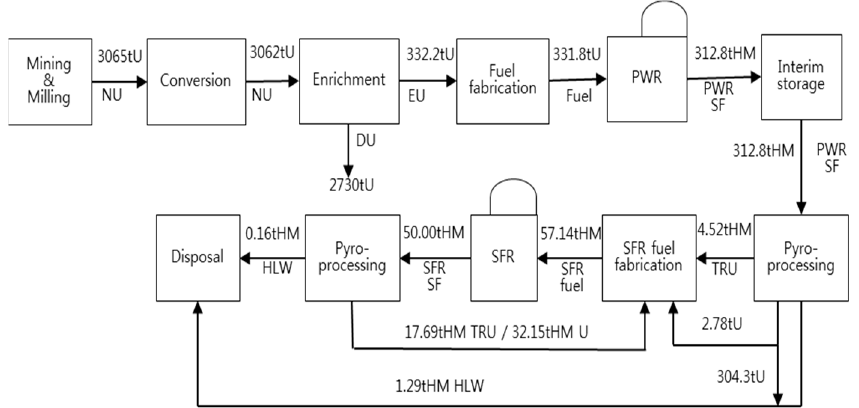
Figure 2. Material flow of direct disposal. Here, NU = natural uranium, DU = depleted uranium, EU = enriched uranium, PWR SF = pressurized-water reactor spent nuclear fuel.